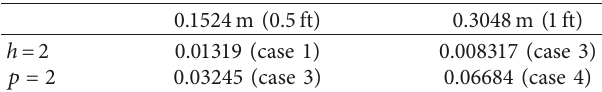
Table 10: Difference between consistent and average mapping (L norm).